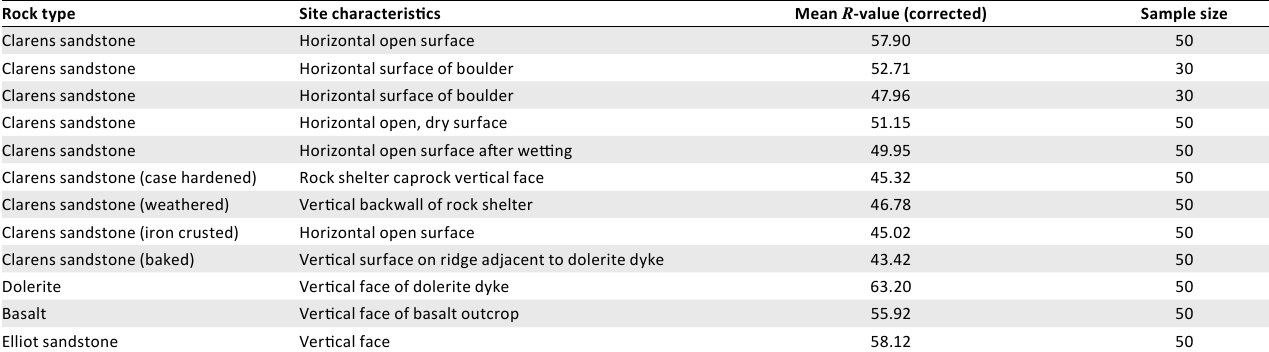
TABLE 2: Hardness values as measured with a Schmidt hammer (classic N) for rock types in the Golden Gate Highlands National Park. Rock